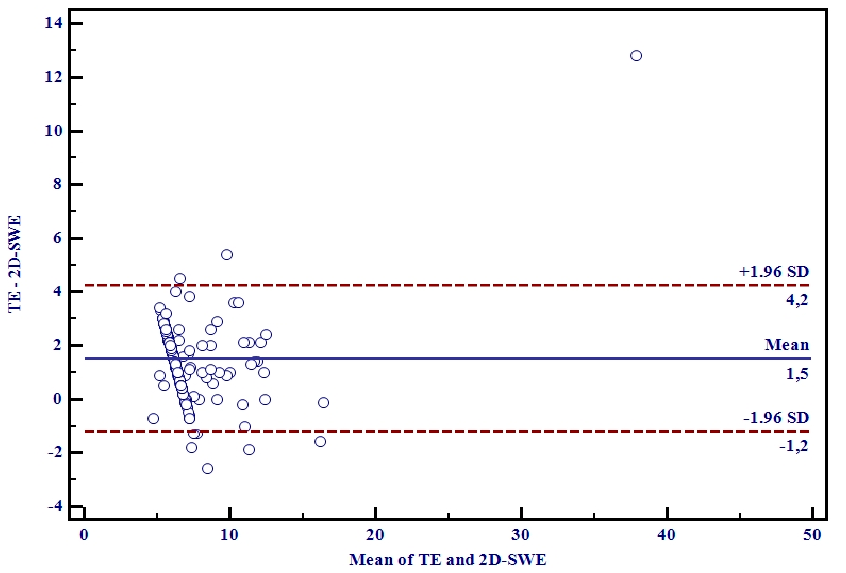
Figure 4. Bland-Altman plots of differences between TE and 2D-SWE.PLUS measurements. The solid line represents the mean of the difference between the elastography measurements taken with the two techniques; the dashed lines define the limit of agreement: the mean difference is 1.5 ± 0.35. The 95% upper and lower LOA were 4.2 and –1.2, respectively.